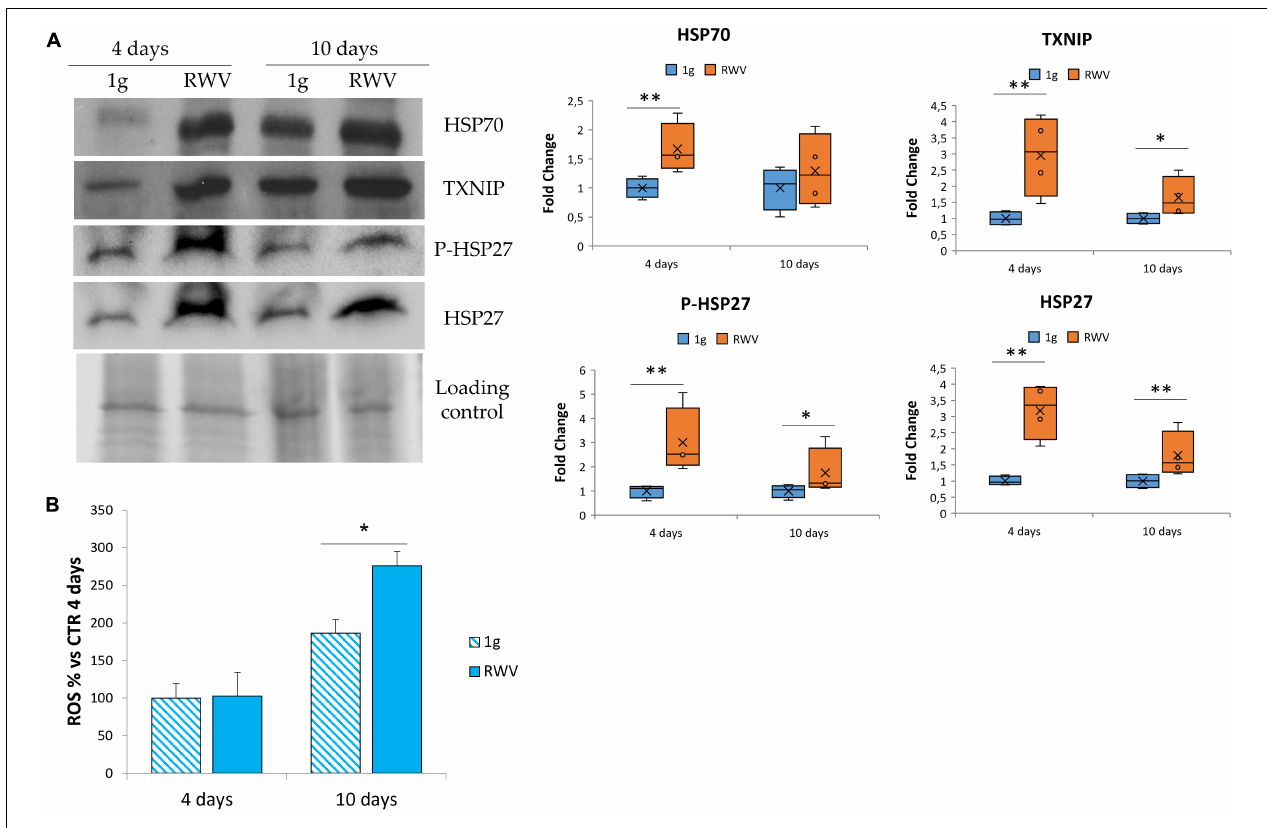
FIGURE 3 | The effect of microgravity on stress response in human dermal microvascular endothelial cell (HDMEC). (A) Western blots performed on HDMEC cultured in microgravity for 4 and 10 days. Antibodies against TXNIP, HSP70, HSP27, and P-HSP27 were used and normalized on control loading. Densitometric analysis of the blot shown is reported on the right. (B) Reactive oxygen species production in HDMEC grown for 4 and 10 days in microgravity was analyzed using 2 (cid:48) -7 (cid:48) -dichlorofluorescein diacetate. The results were expressed as % compared to the sample grown in 1g condition for 4 days. * P < 0.05 and ** P < 0.01.